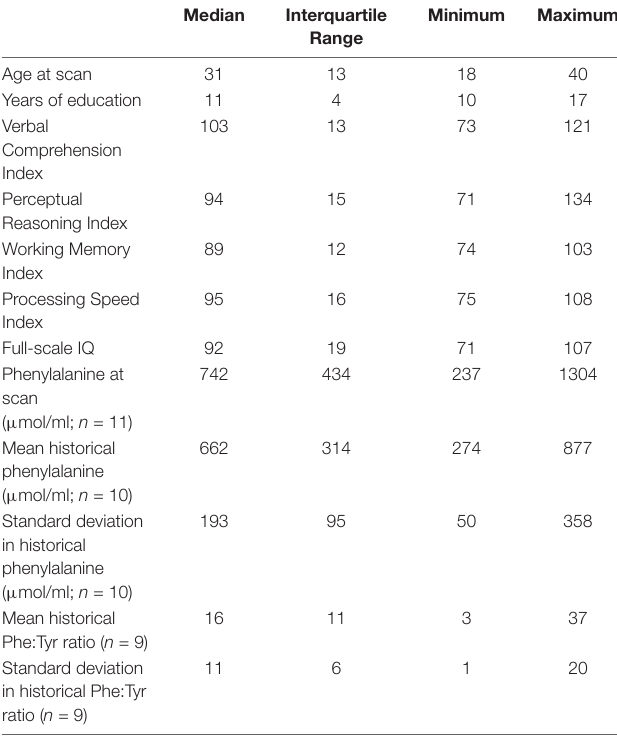
TABLE 1 | Demographics, intellectual functions, and blood